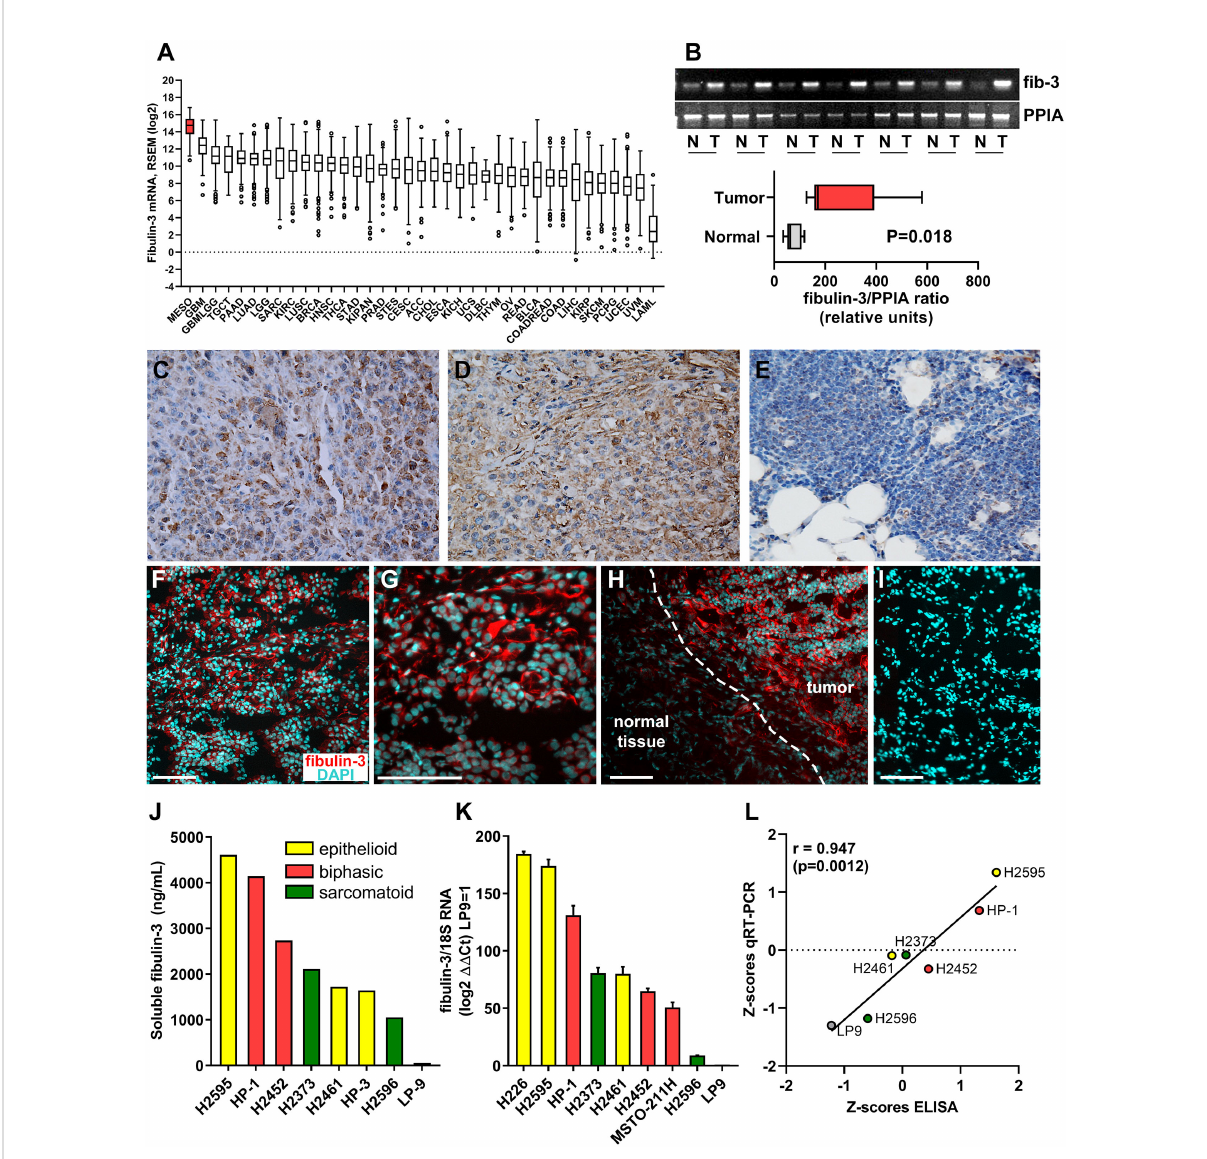
Table IV. (B) Comparative mRNA expression of fi bulin-3 ( fi b-3 ) and the loading control cyclophilin ( PPIA ) for MPM tumor ( T ) and normal adjacent-to-tumor ( N ) tissues. (C-E) Conventional immunohistochemical detection of fi bulin-3 in epithelioid MPM (C-D) and normal pleura (E) ; images captured at 400x magni fi cation. (F-I) Immuno fl uorescence detection of fi bulin-3 in epithelioid MPM (F-G) and adjacent normal tissue (H) ; notice the abundant pericellular staining only in the tumor tissue; this staining is speci fi c and not observed in absence of primary antibody (I) . Bars= 100 µm. (J-L) Fibulin-3 expression in MPM cells (originated from different tumor subtypes) and normal mesothelial cells was detected by ELISA for the protein secreted to the culture medium (J) or by qRT-PCR (K) . Both measures showed signi fi cant positive correlation (L)